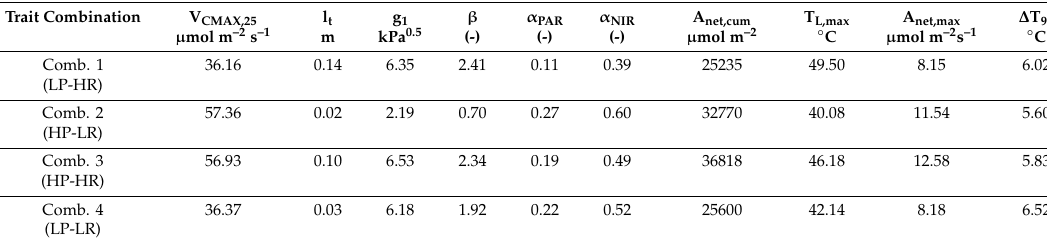
Table 2. Combination of traits used to perform the climate scenarios analyses and the resulting values of the assimilation and thermal metrics for the growing season 2005. LP-HR: Low Productivity-High Risk of thermal damage; HP-LR: High Productivity-Low Risk of thermal damage; HP-HR: High Productivity-High Risk of thermal damage; LP-LR: Low Productivity-Low Risk of thermal damage. Trait